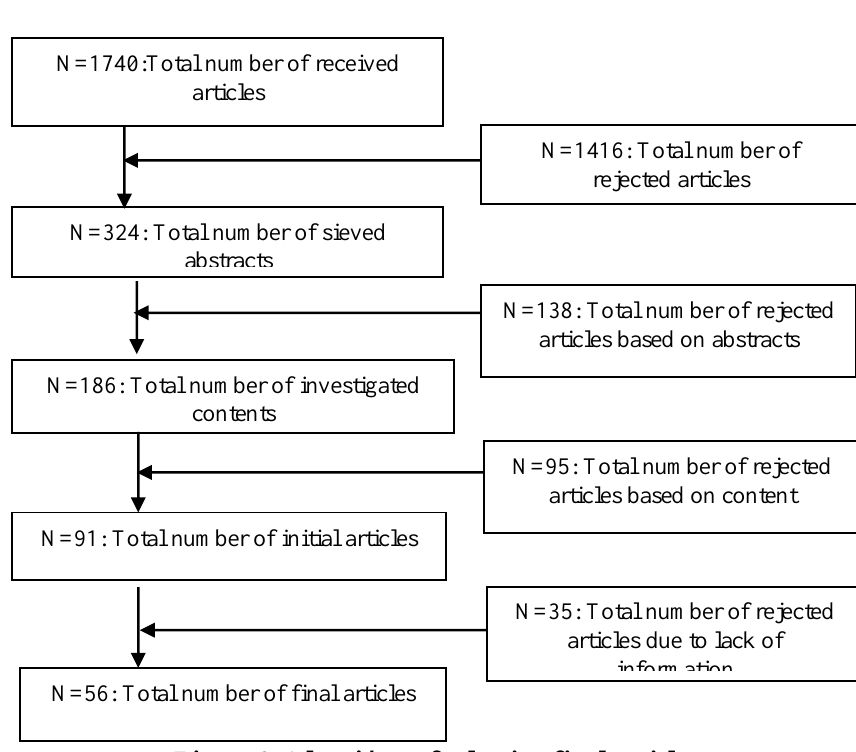
Figure 2. Algorithm of selecting final